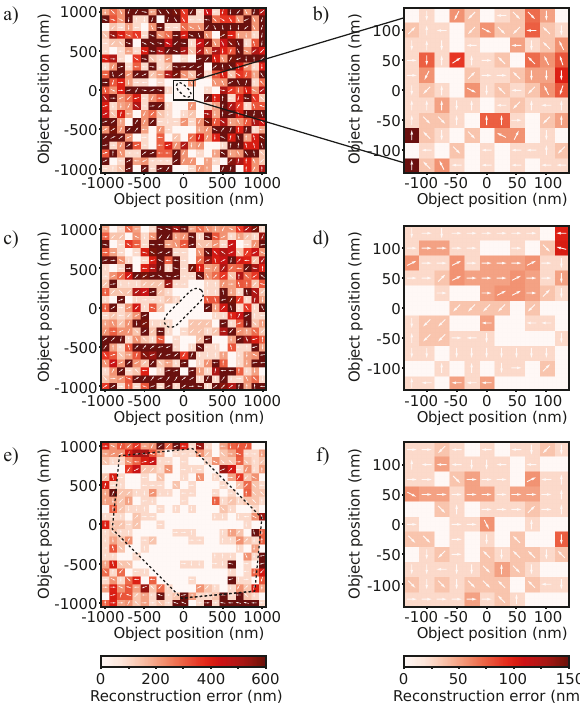
Figure 4: Position estimates for signal data retrieved by the localization algorithm versus actual position for a (a and b) small aperture, (c and d) large aperture and (e and f) two-dimensional aperture array. The color scale shows the error between the reconstructed position and the known position. For incorrect estimates, arrows indicate the direction of the error. The reconstruction error is measured across an area of (a, c and e) 2 × 2 μ m in 100 nm steps, and (b, d and f) 0 . 25 × 0 . 25 μ m in 25 nm steps. In (a, c and e), the outline of the transducer is indicated